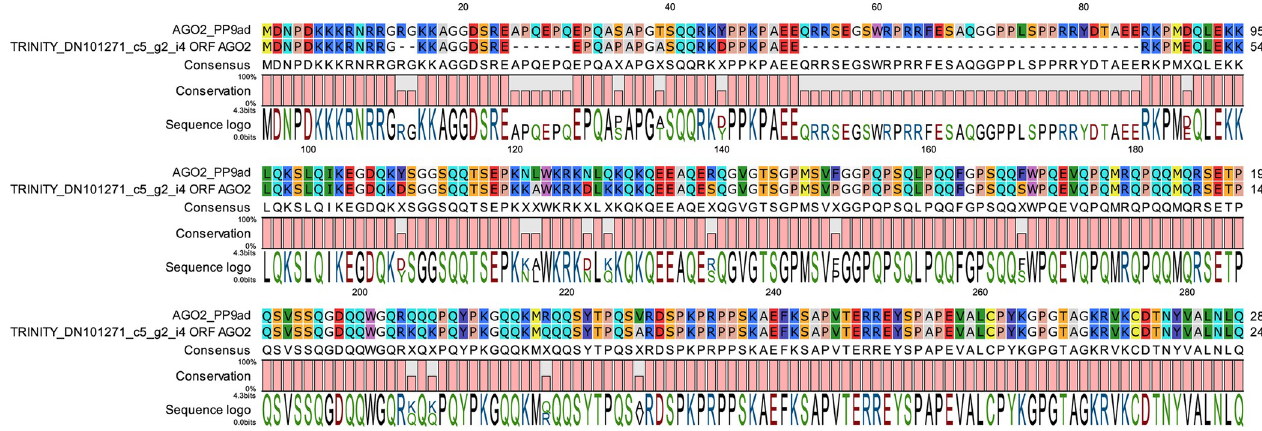
Fig 3. Consensus between translated P . papatasi transcriptomics derived and PP9ad cell Ago2 sequences. The Ago2 amino acid sequences differed in the N terminal region mainly, as shown in partial sequence indicated; the PP9ad cDNA encoding a longer protein.